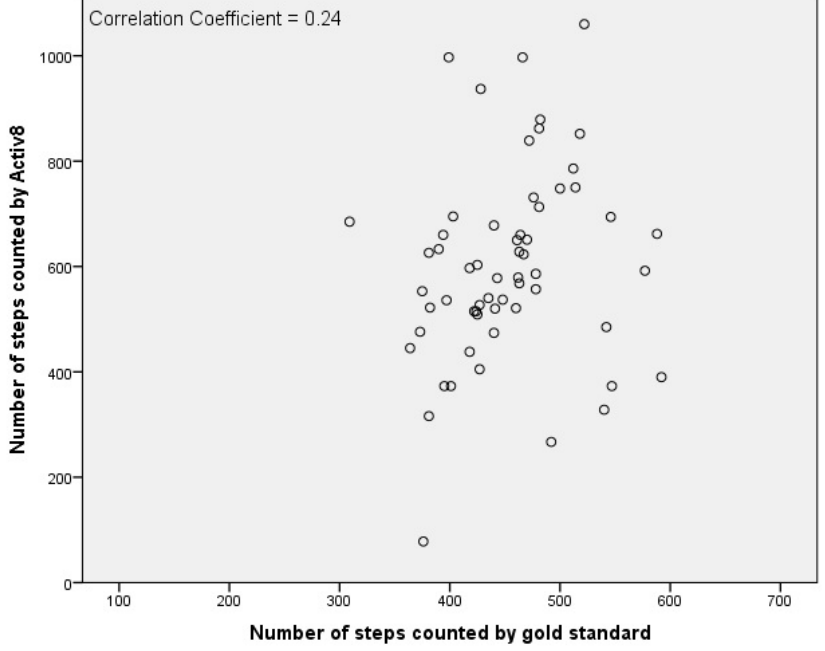
Figure 2. Scatterplot of the number of steps counted by Activ8 and the gold standard.